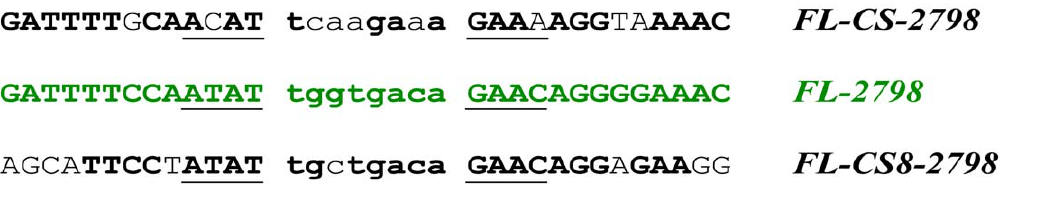
Figure 8. Two FRT -like sequences that are highly homologous to FL-2798 . Identical nucleotides between the FRT -like sequences are shown in bold. Spacer sequences are shown in small letters. 8-proximal regions in the sequences are underlined. FL-CS8-2798 has the same 8-proximal region as FL-2798 but fewer overall identical nucleotides than has FL-CS-2798 .